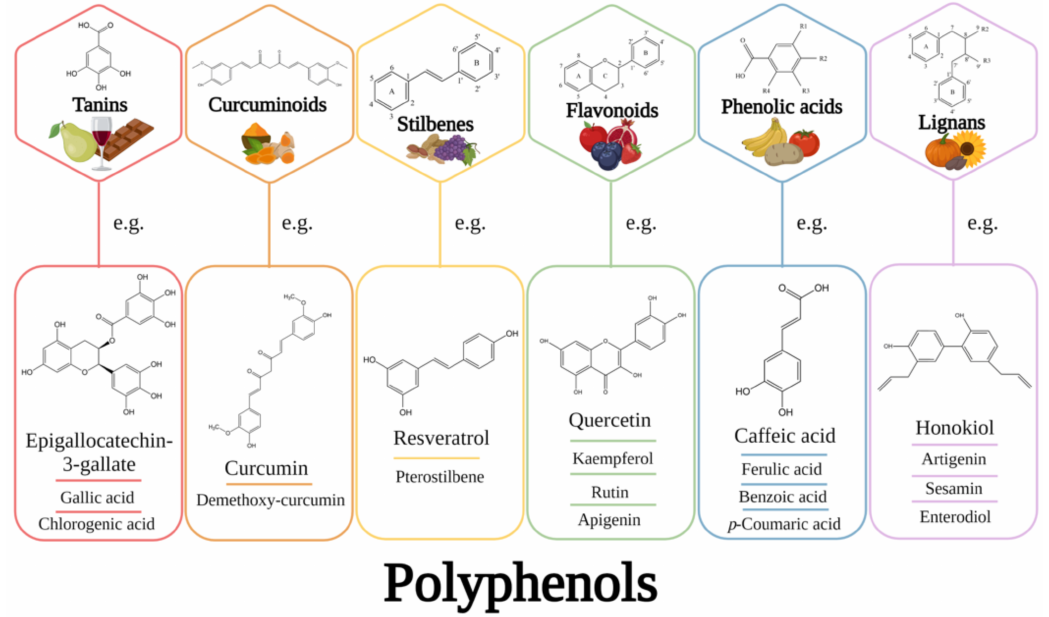
Figure 1. Classification of polyphenols and their biological